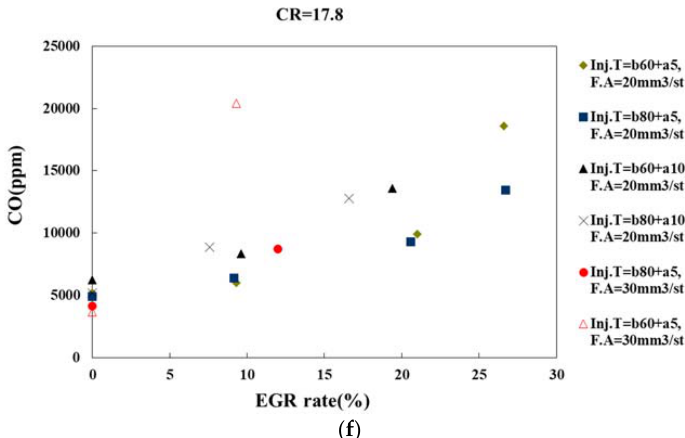
Figure 10. Performance characteristics of IMEP and emission applied to EGR (compression ratio: 17.8, 1400 rpm, injection amount: 20, 30 mm 3 /stroke). ( a ) Variation of air ‐ fuel ratio according to EGR; ( b ) Variation of IMEP according to EGR; ( c ) Variation of NO x according to EGR; ( d ) Variation of Smoke according to EGR; ( e ) Variation of HC according to EGR; ( f ) Variation of CO according to EGR.